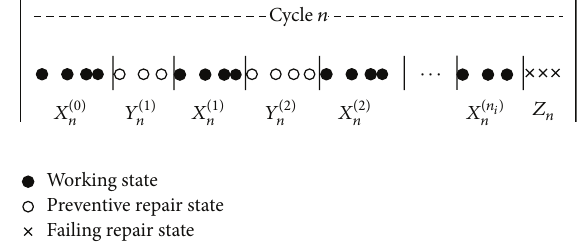
Figure 1: A possible course of the battery in a